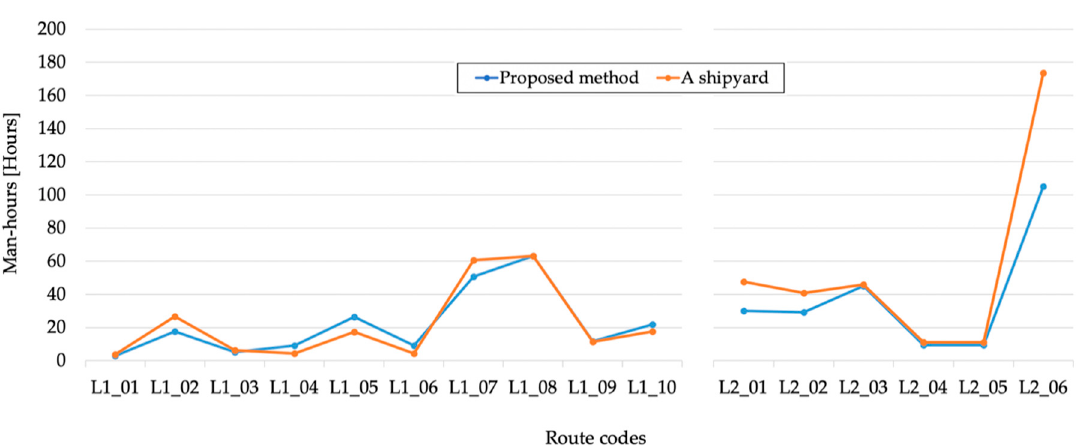
Figure 8. Comparison between production metrics obtained via the proposed method (blue) and shipyard data (orange): L1-level (left) and L2-level (right) blocks. Table 6. Deviation of production metrics obtained via the proposed method from shipyard data. Route